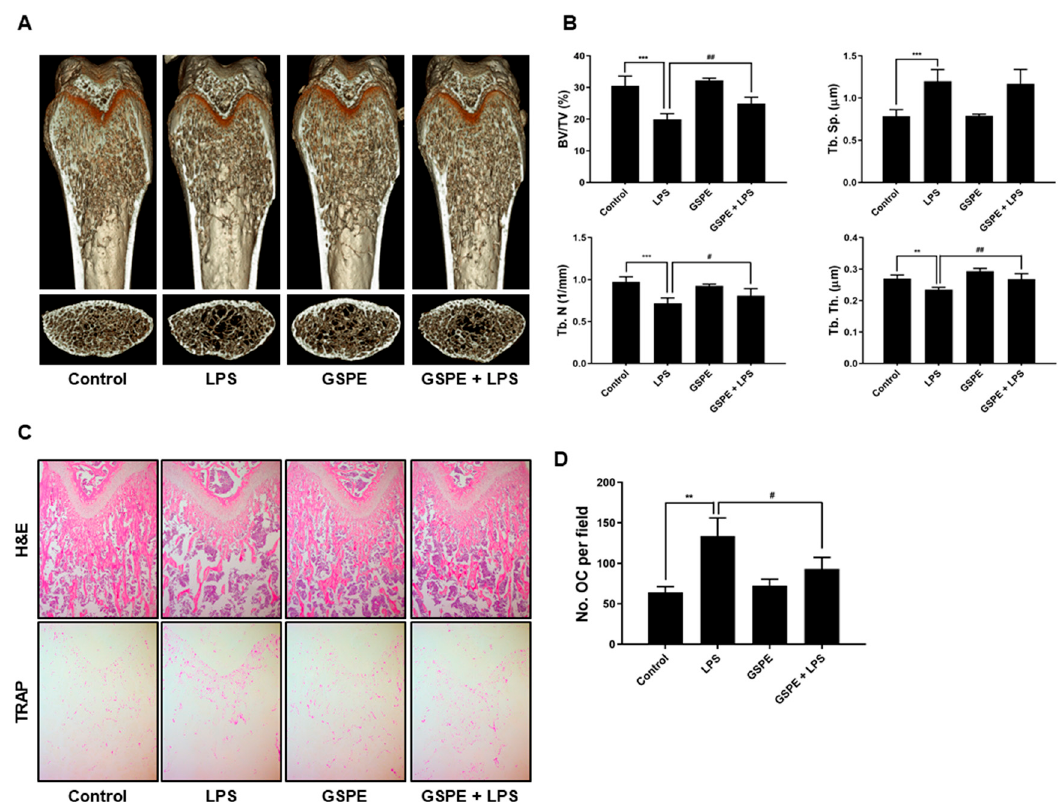
Figure 1. GSPE inhibits LPS-induced inflammatory bone loss in vivo. ( A ) GSPE (200 mg / kg) or PBS was administered orally on the day before LPS injection (5 mg / kg) to mice. LPS was injected intraperitoneally on days 1 and 4. GSPE or PBS was administered orally every other day for 8 days. Mice were euthanized 8 days after the first LPS injection and radiographs of the longitudinal and transverse sections of the proximal femur were obtained using a micro-CT apparatus. ( B ) The BV / TV, Tb.Sp, Tb.Th, and Tb.N of the femurs were determined by analyzing the micro-CT data using INFINITT-Xelis. ( C ) Dissected femurs were fixed, decalcified, paraffin embedded, and sectioned. Sections were stained with H&E and TRAP. The pink area stained by TRAP represents osteoclasts (OCs). ( D ) Number of osteoclasts per field of tissue was analyzed using the histomorphometric results. The OC numbers per field are the representative of three independent experiments, and 5 files per slide were quantified. ** p < 0.01; *** p < 0.001 versus the control group, # p < 0.05; ## p < 0.01 versus